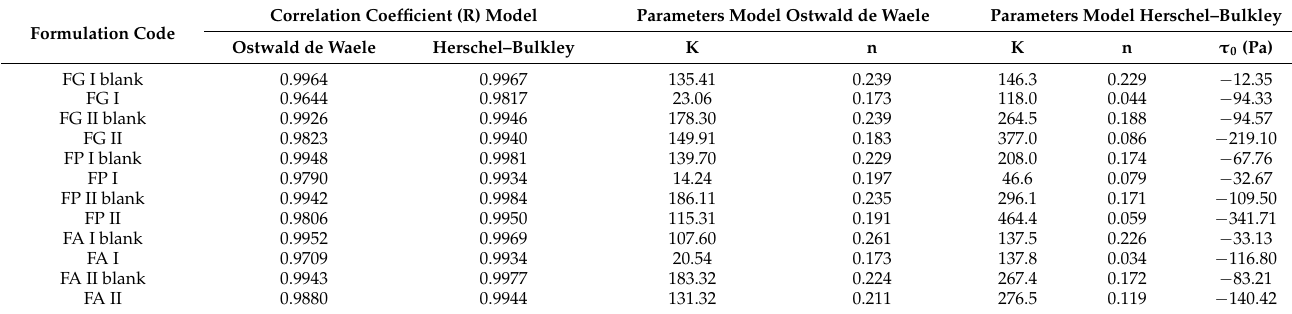
Table 2. Regression parameters of rheological models (Ostwald de Waele and Herschel–Bulkley) and rheological parameters of Carbopol 940-based hydrogels were obtained by fitting the ascending portion of the rheograms with the respective models.